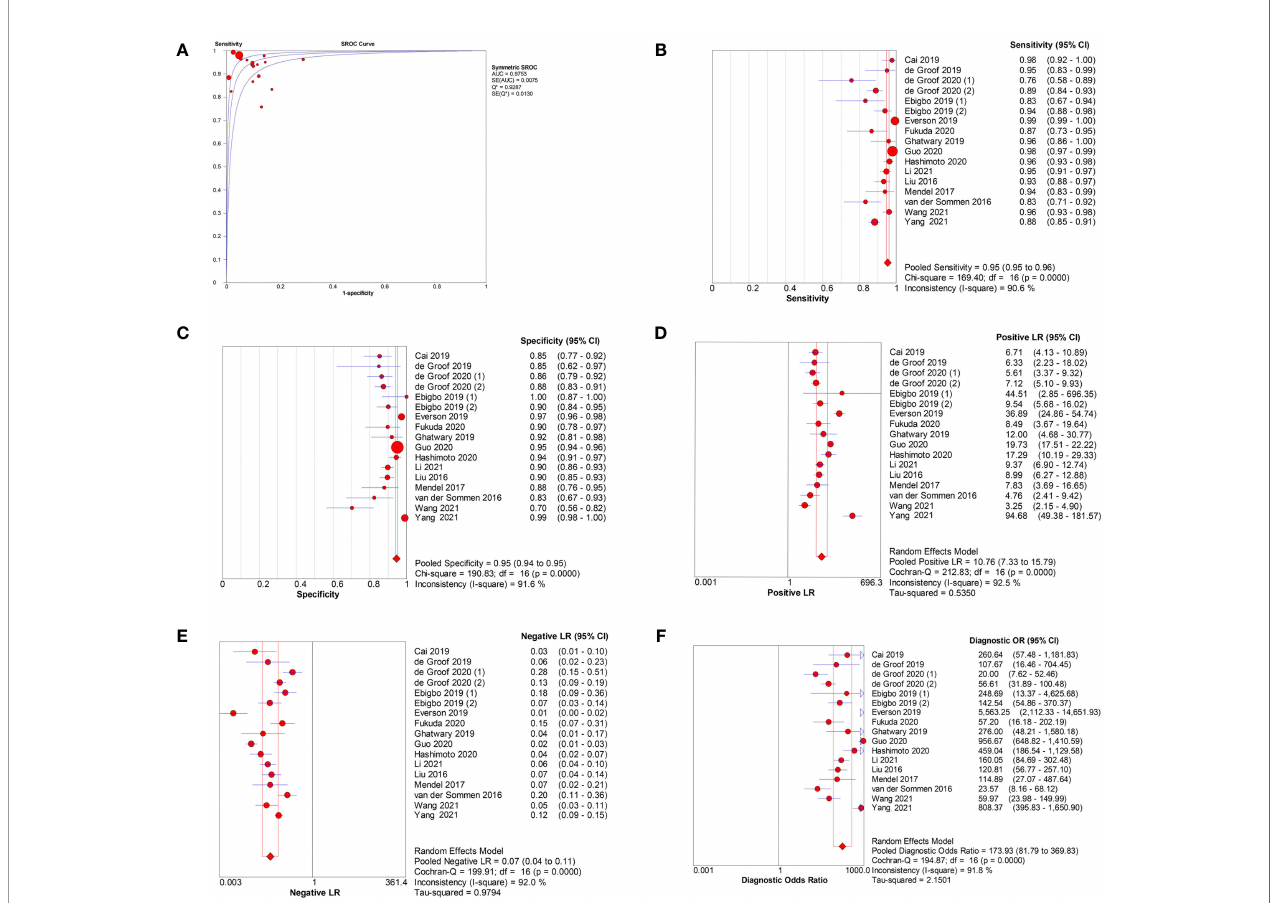
FIGURE 3 | Meta-analysis of AI-assisted EEC diagnosis (image-based analysis). (A) SROC curve. (B) Pooled sensitivity. (C) Pooled speci fi city. (D) Pooled PLR. (E) Pooled NLR. (F) Pooled